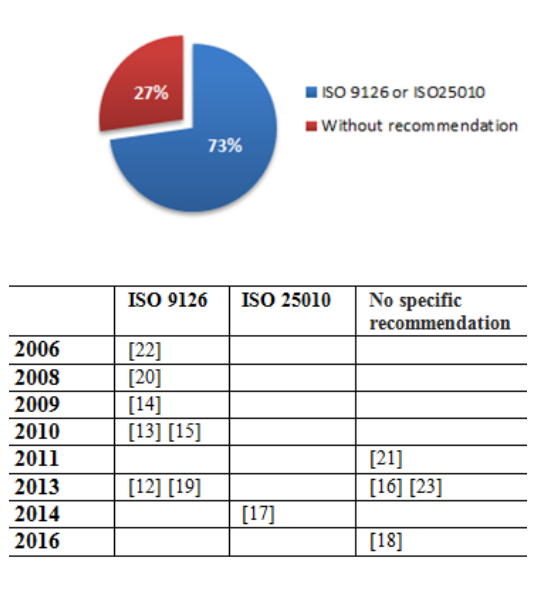
Figure 4 . Results of recommendations study